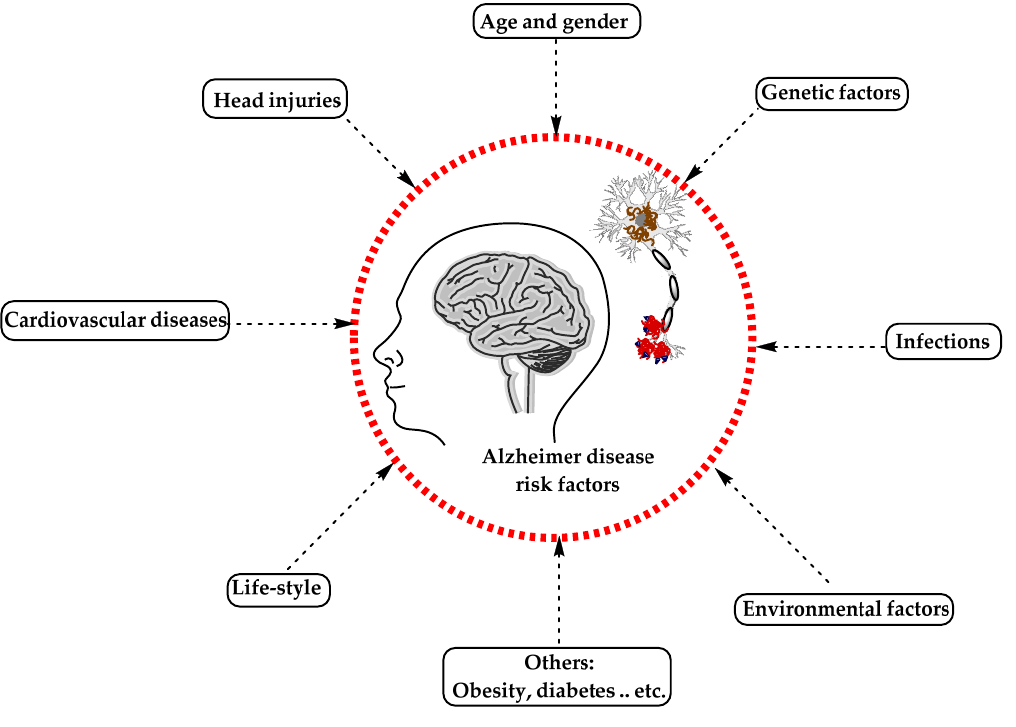
Figure 2. The risk factors for Alzheimer’s disease. Molecules 2020 , 25 , x FOR PEER REVIEW